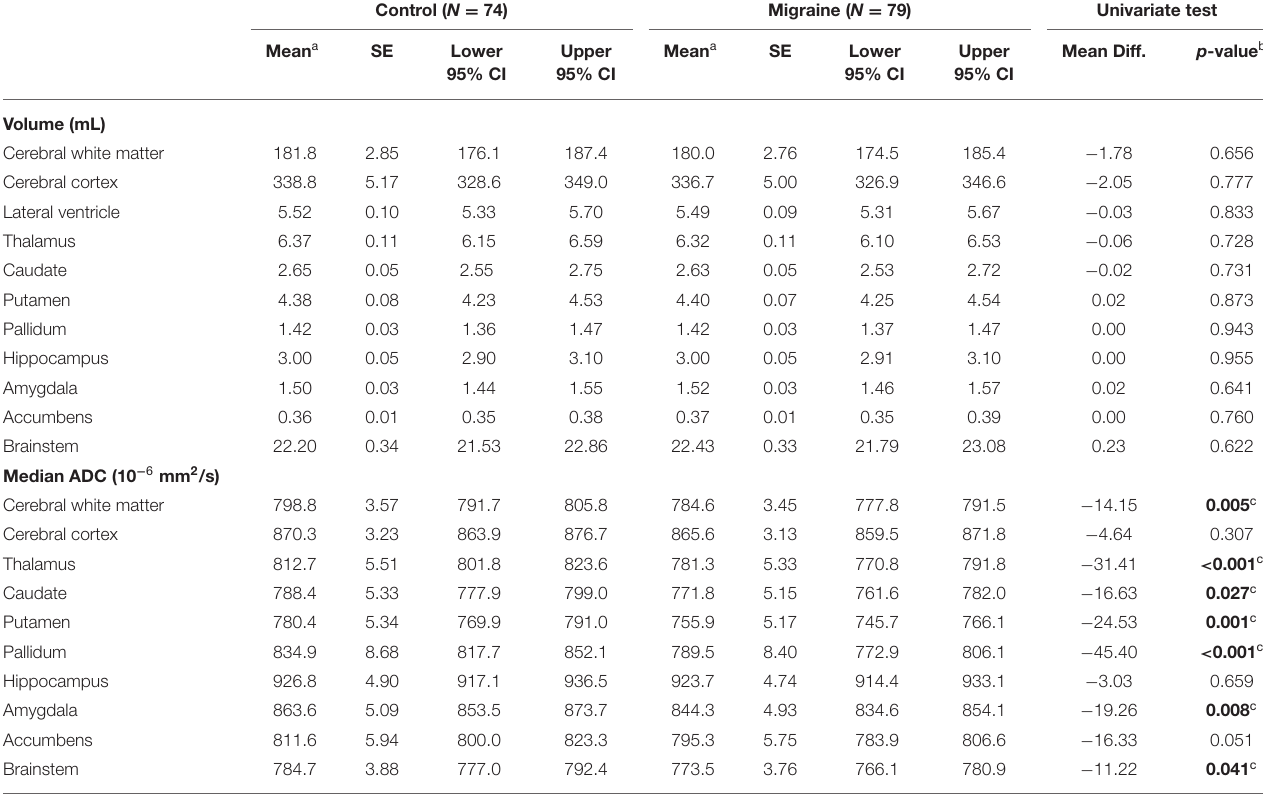
TABLE 2 | Volumetric and apparent diffusion coefficient values by brain region.